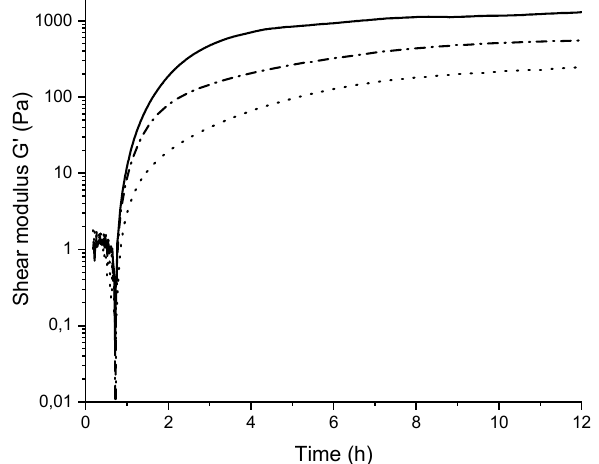
Figure 4. Shear modulus over time for 1.0% w/v mixed stipe alginate and functionalized POA (P 0 = 0.08) upon mixture with CaCO 3 and GDL (at 0 h, 15 mM CaCO 3 ), resulting in unsaturated Ca–alginate gels. Fraction of POA, W POA = 0.00 (solid line), fraction of POA, WP OA = 0.50 (-.-.-.-.-.-.-), fraction of POA, W POA = 0.75 (……). POA = partially oxidized alginate.